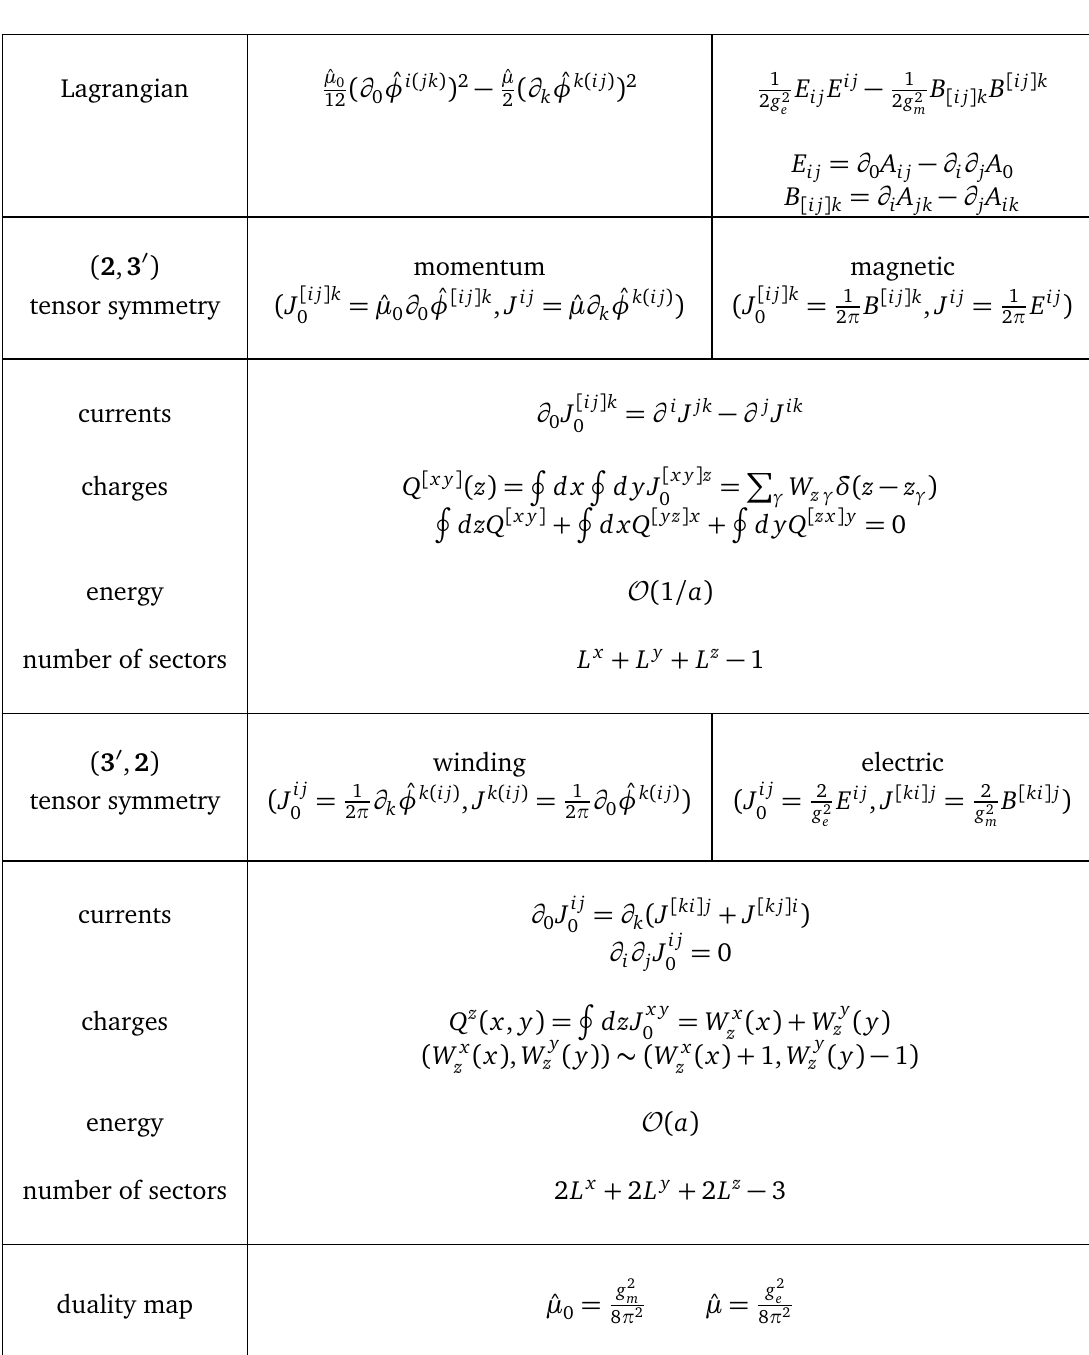
Table 3: Global symmetries of the U ( 1 ) tensor gauge theory A and its dual ˆ φ . Above we have only shown charges for some directions, while the others admit similar ex- pressions. See [ 2 ] for more